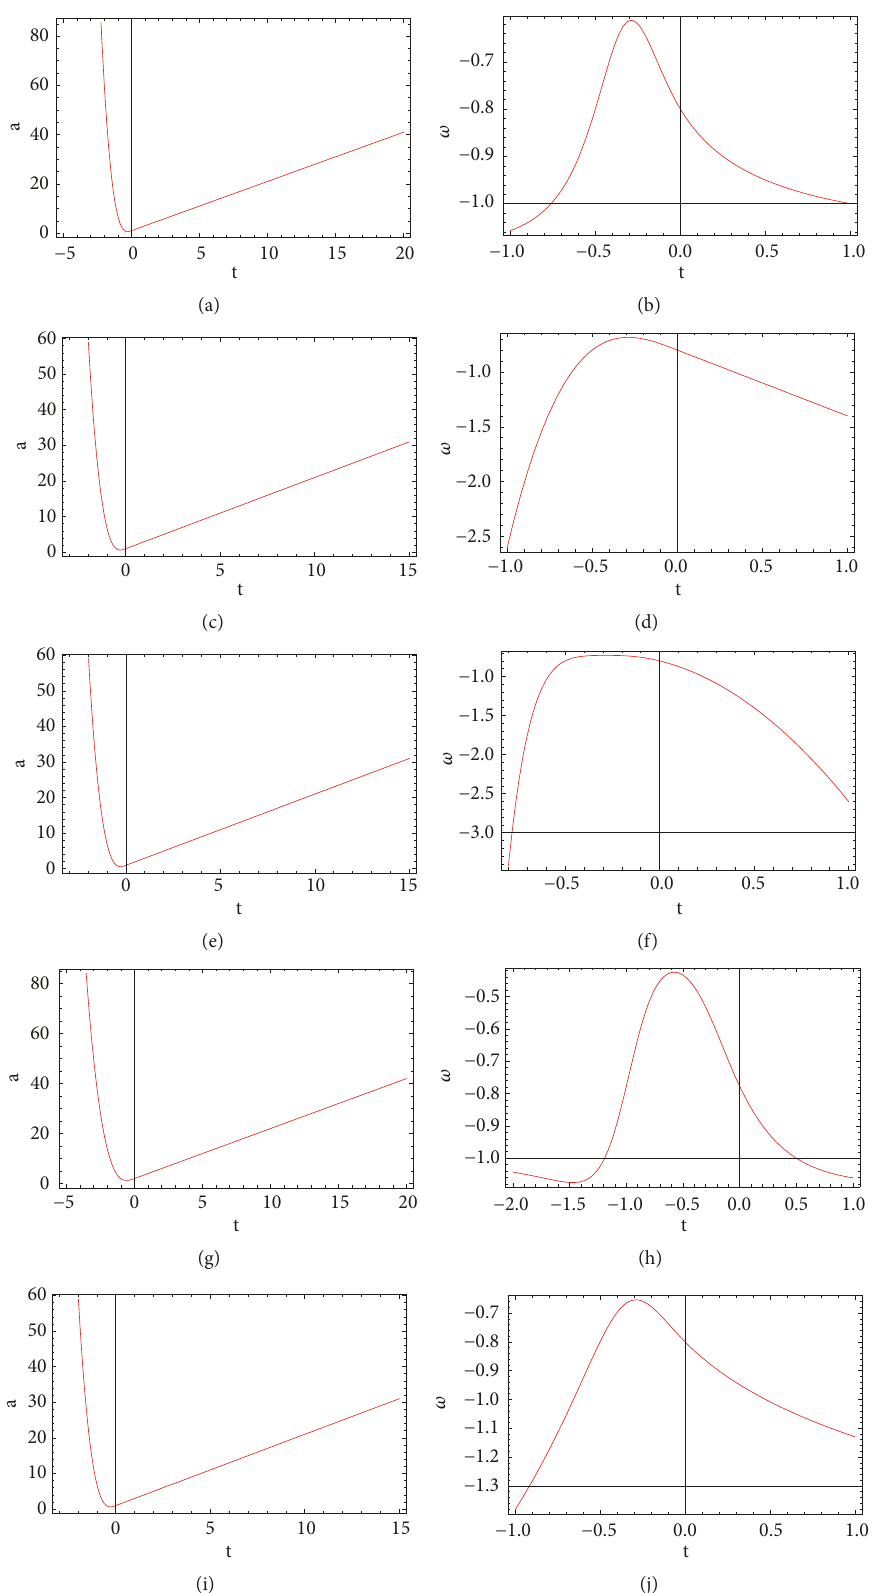
Figure 6: (a) and (b) (linear), (c) and (d) (CPL), (e) and (f) (JBP), (g) and (h) (ASSS), and (i) and (j) (Efstathiou) show the variation of scale factor 𝑎(𝑡) ((a), (c), (e), (g), and (i)) and EoS parameter 𝜔 ((b), (d), (f), (h), and (j)) with the variation in cosmic time 𝑡 for the different parameterization